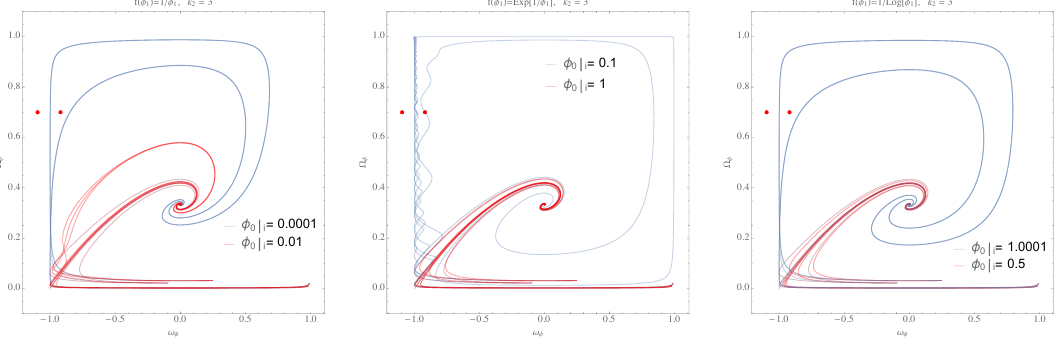
Figure 4 . ((cid:10) (cid:30) ; ! (cid:30) ) plane evolution for matter dominated initial conditions and k